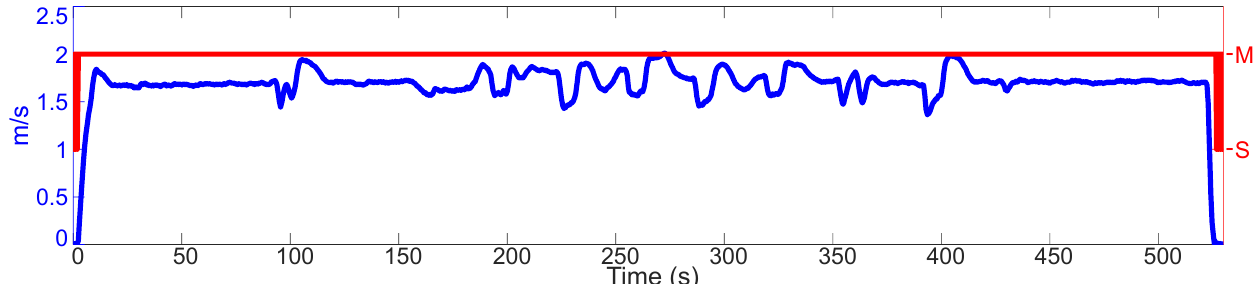
Figure 6. Shown is the RF output (red, S = standstill, M = motion) and the velocity over ground of the vehicle (blue). Vehicle: 3rd Gen. Smart ForTwo. Motorization: Electric Drive. Power source: